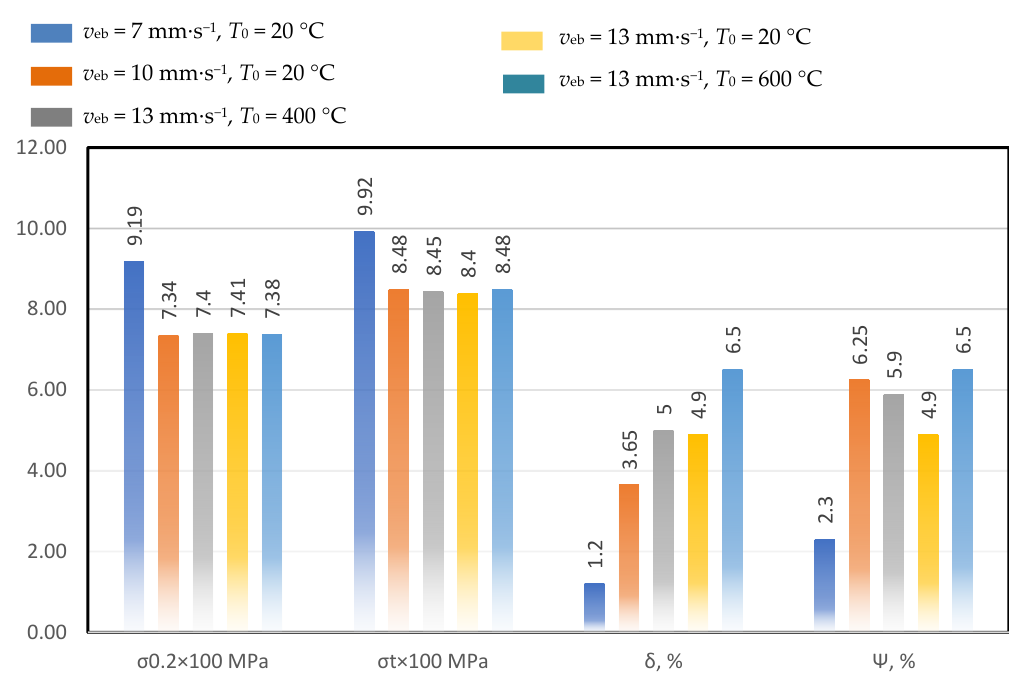
Figure 17. Mechanical properties of (Ti-TiB)–T110 welded joint material obtained under various modes of electron-beam welding.